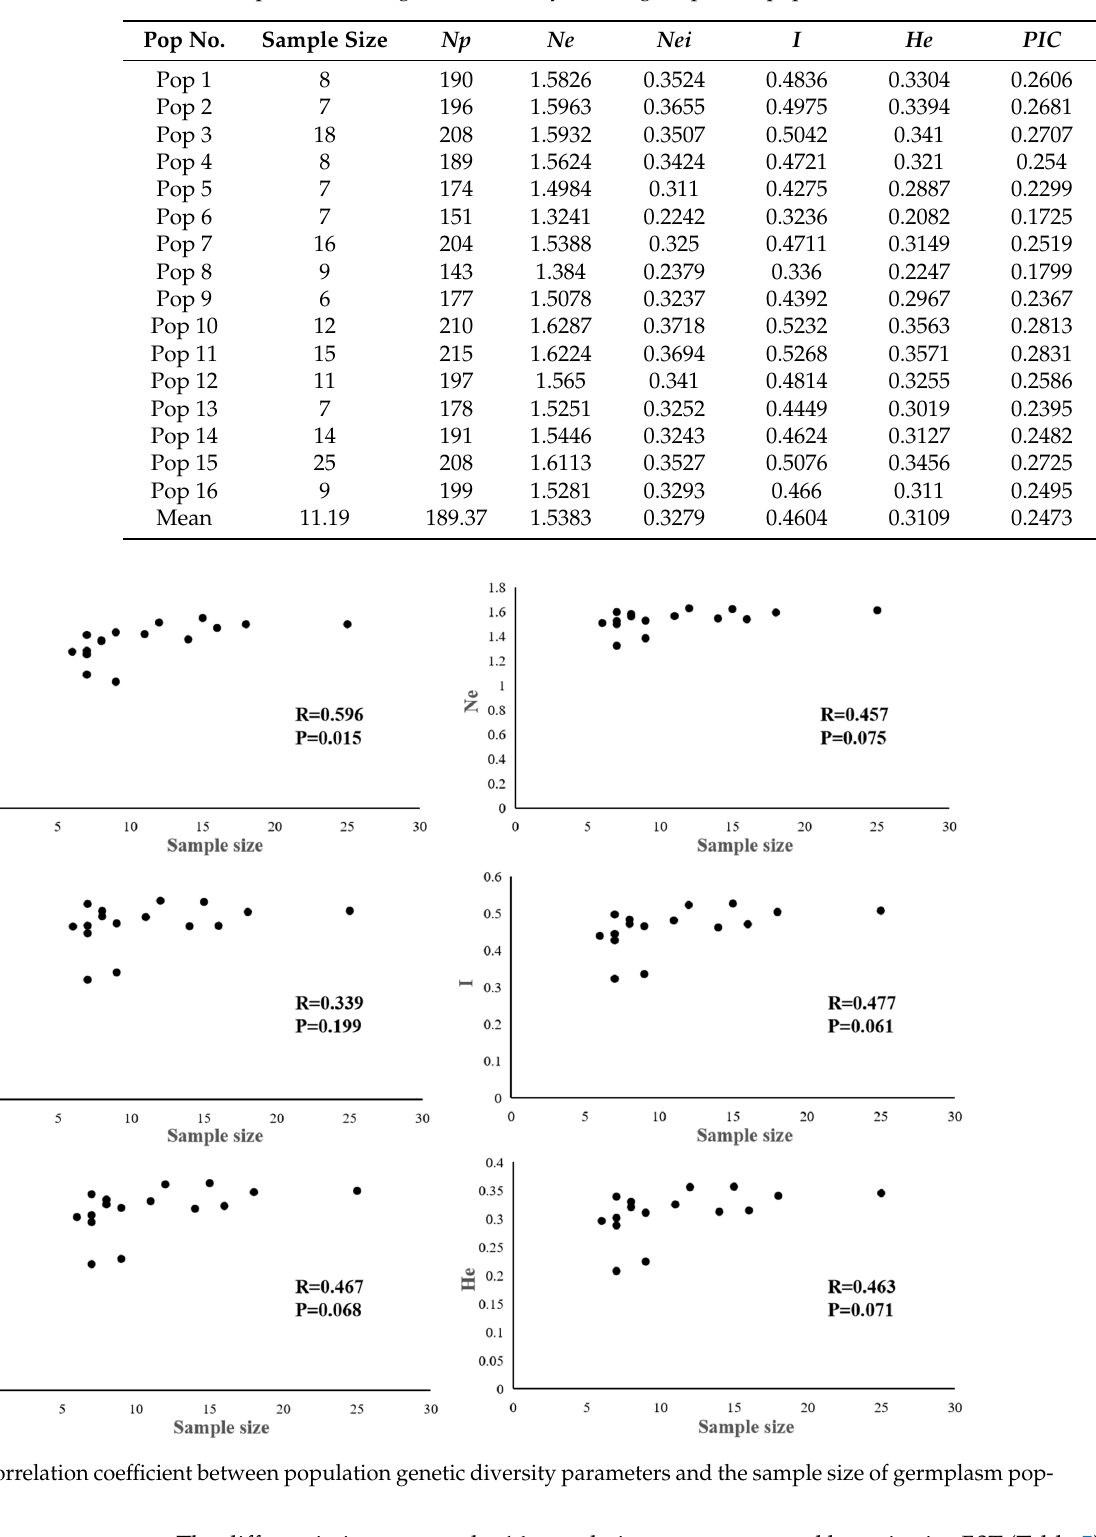
Table 4. Comparison of the genetic diversity for the germplasms populations.